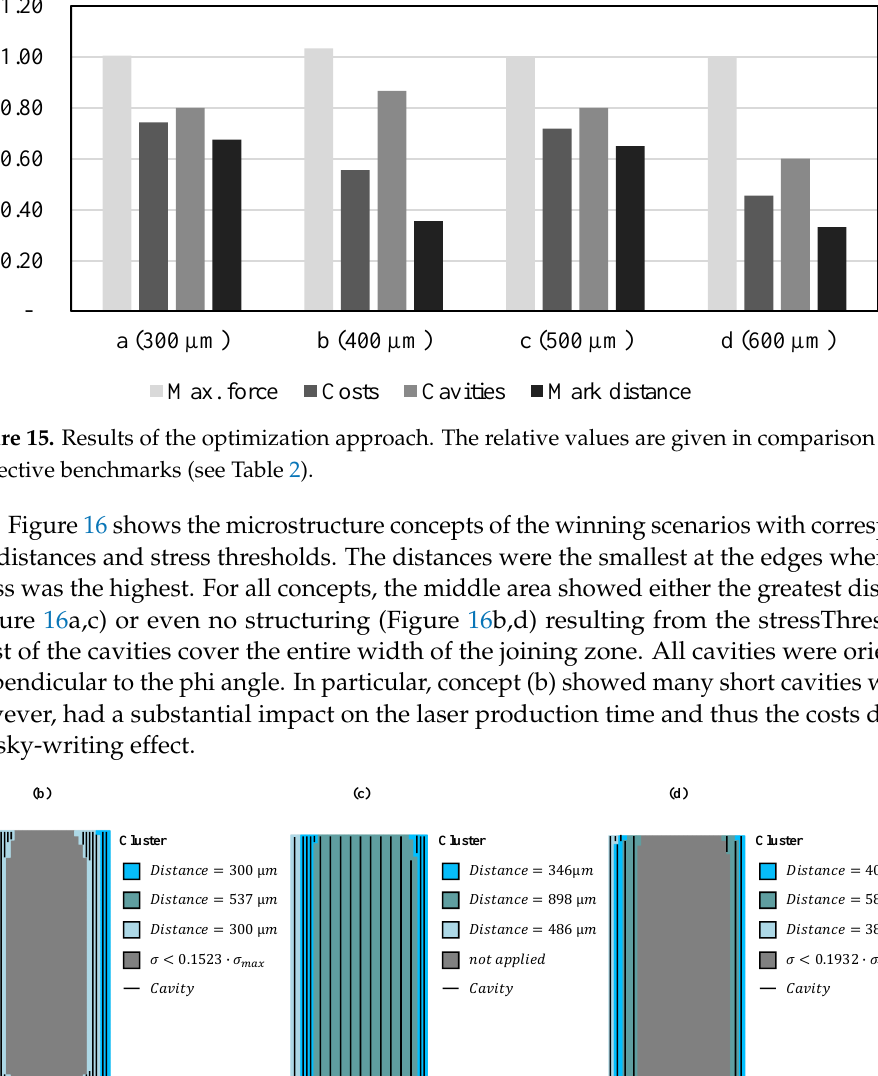
Figure 14. 3D illustration of the cohesive-zone models for different distances.